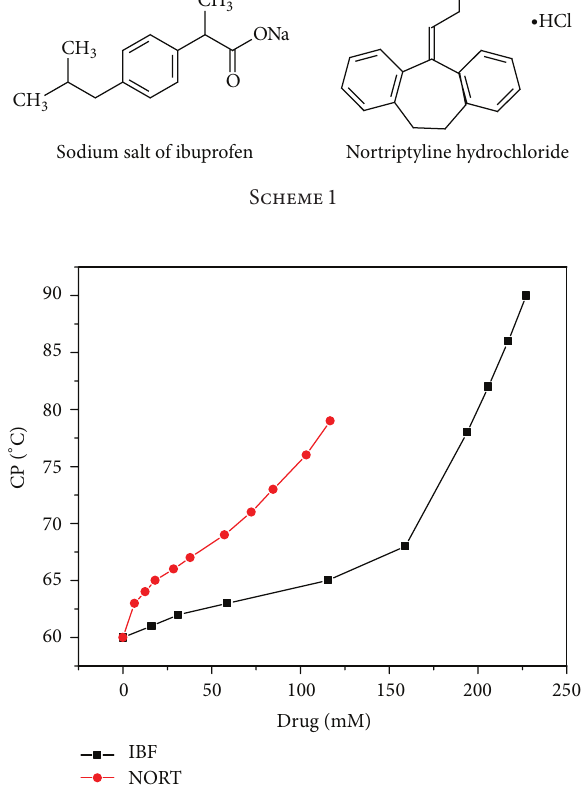
Figure 1: Effect of amphiphilic drugs on the CP of